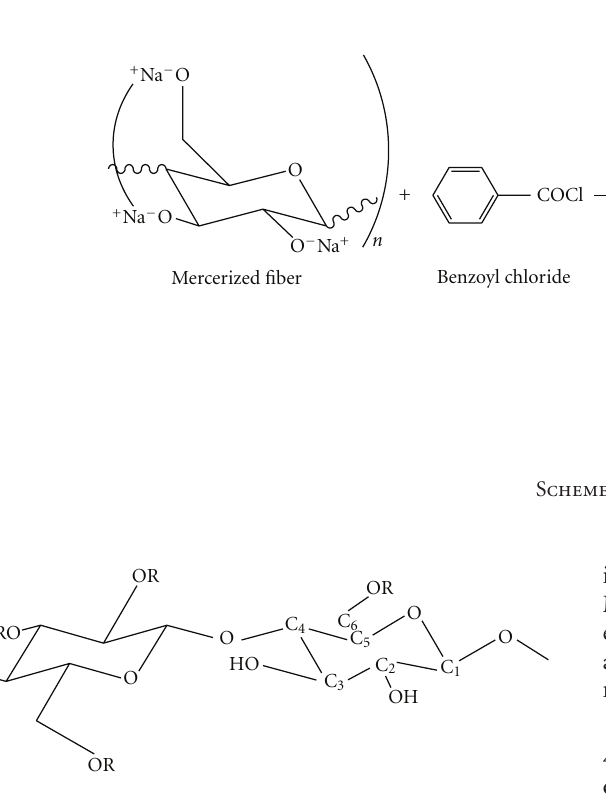
Figure 7: Structure of cellulose